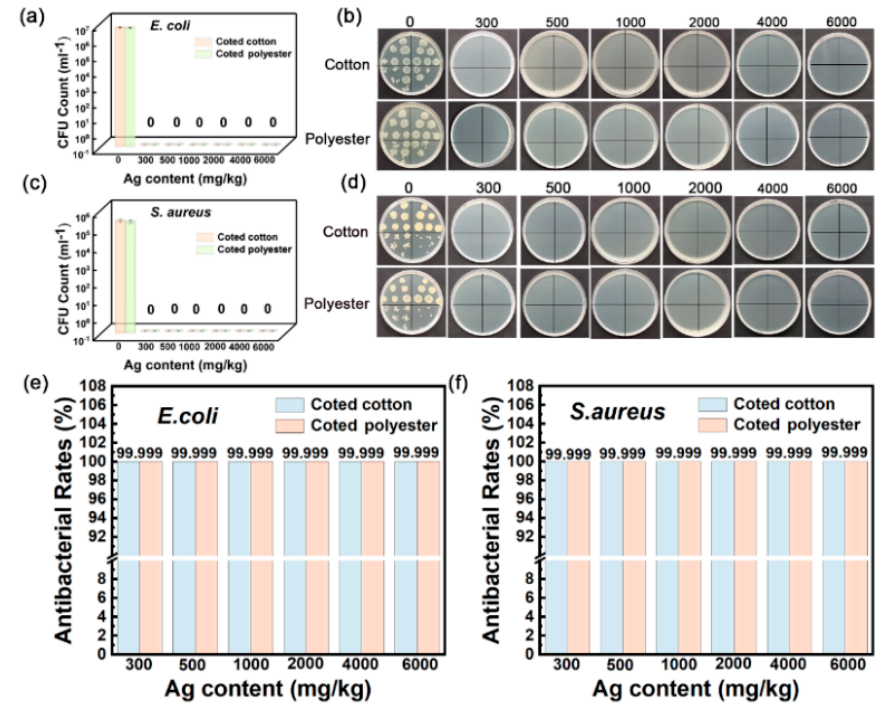
Figure 8. Antibacterial activities of nanosilver-glue-coated cotton and polyester fabrics against E. coli and S. aureus . ( a , c ) CFU counts of cotton and polyester fabrics after incubation. ( b , d ) Corresponding photos of E. coli and S. aureus colonies in culture dishes. ( e , f ) Antibacterial rates of coated cotton and polyester fabrics against E. coli and S. aureus .